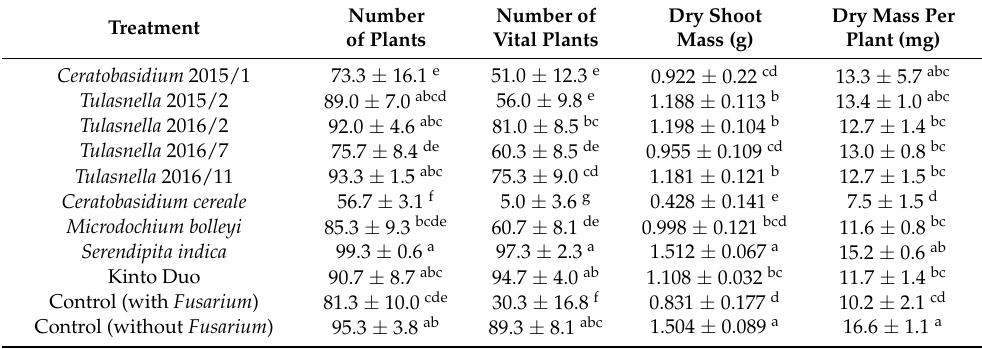
Table 5. Evaluated parameters of Experiment 3 include numbers of plants emerged from 100 grains sown, and numbers of vital plants lacking any symptoms of necrosis or chlorosis caused by Fusar- ium culmorum . Dry shoot mass (g) and dry shoot mass per emerged plant (mg). Data represent means ± SD ( n = 3) followed by the same letter (within the column) if there was no statistical difference according to LSD 0.05